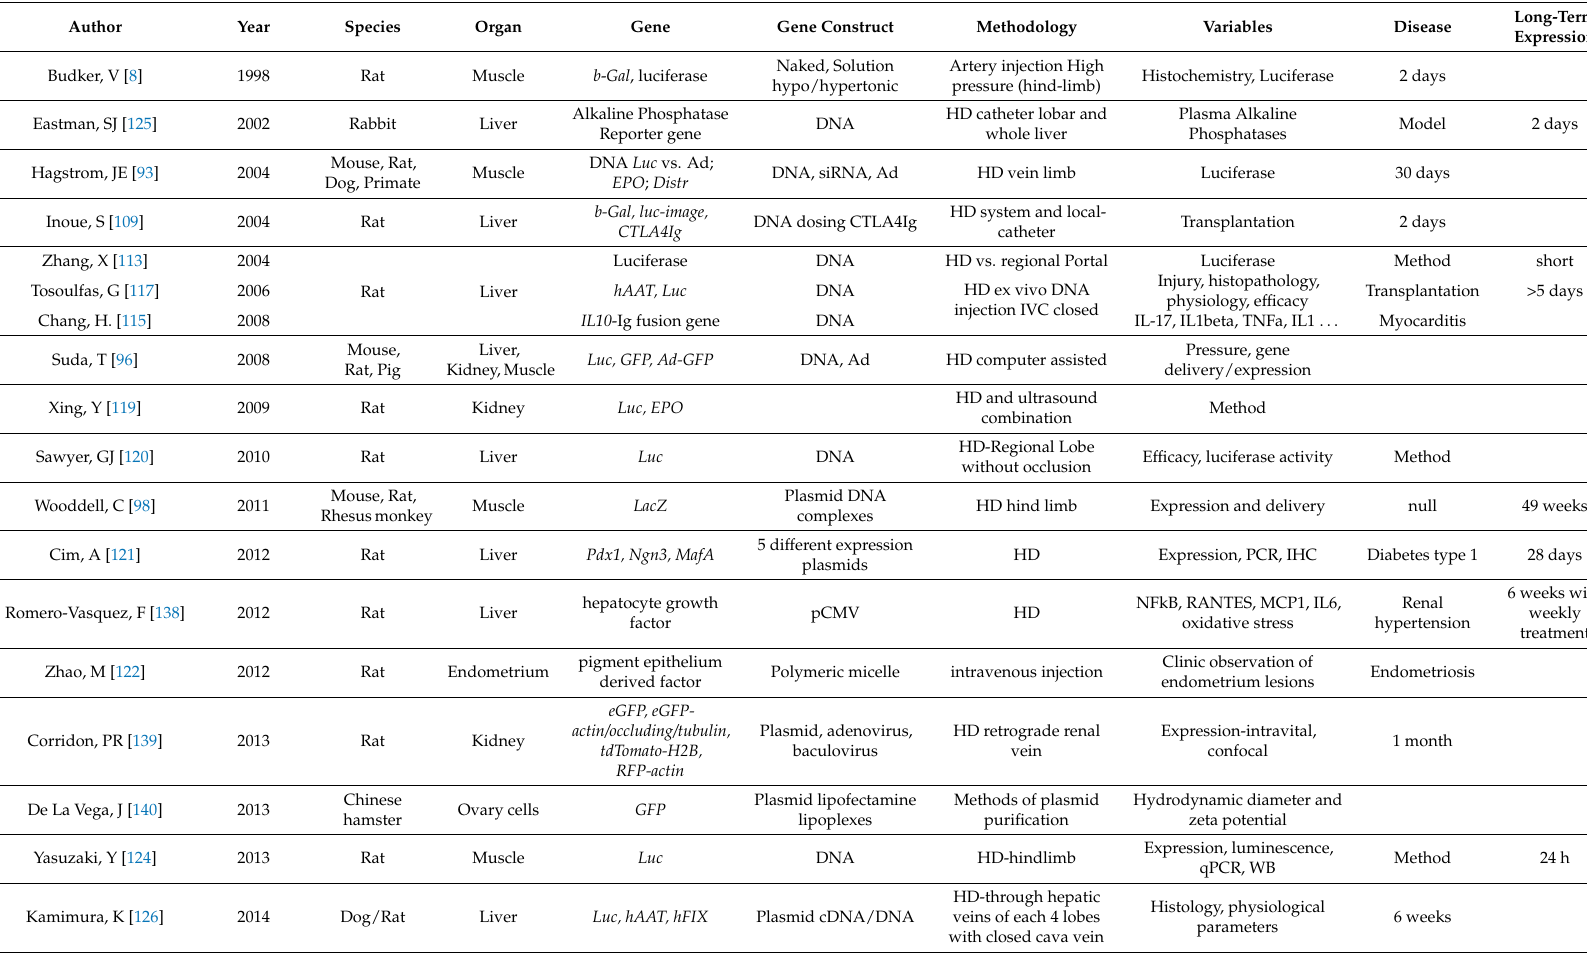
Table 2. Hydrodynamic gene transfer works performed in mid-size animals. The table shows the author of each work, the publication year, the animal model studied, the target organ assayed, gene and gene construction, injection methodology, variables evaluated, disease of interest and effect